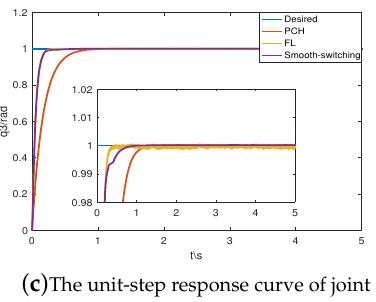
( c ) The unit-step response curve of joint 3. Figure 4. Unit-step response curves of three joints with σ = 0.01.